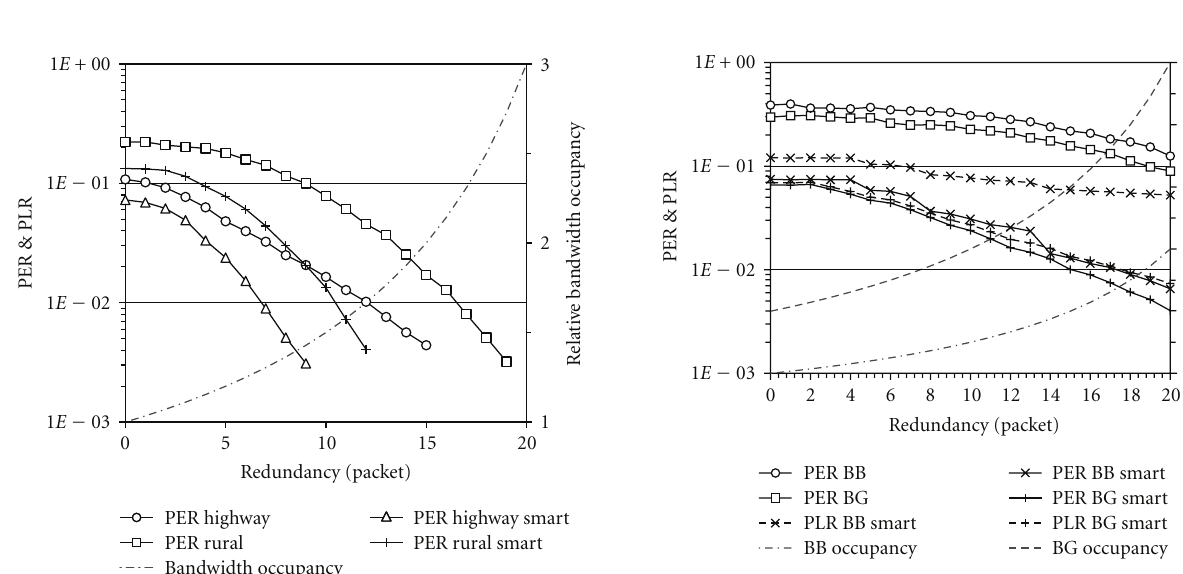
Figure 12: PER, PLR, and bandwidth occupancy versus redundancy with RSE (30, k ) in urban